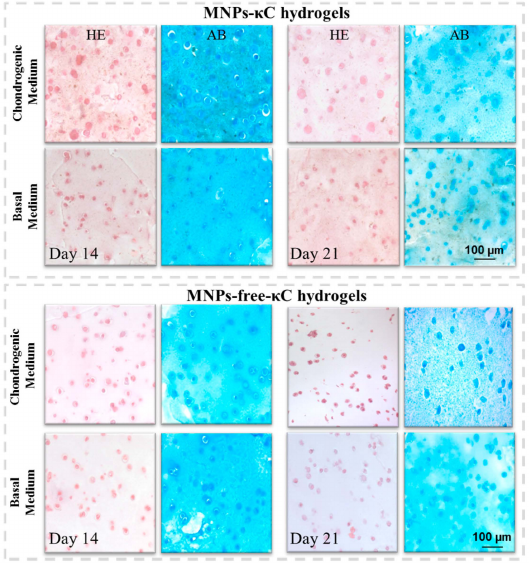
Figure 4. Light microscopy images of paraffin-embedded histological sections of hASCs laden in MNPs- and MNPs-free- κ C hydrogels stained for hematoxylin-eosin (H&E) and Alcian Blue (AB). The MNPs were triggered by the actuation of an external magnetic field. Original magnification 20 ˆ and